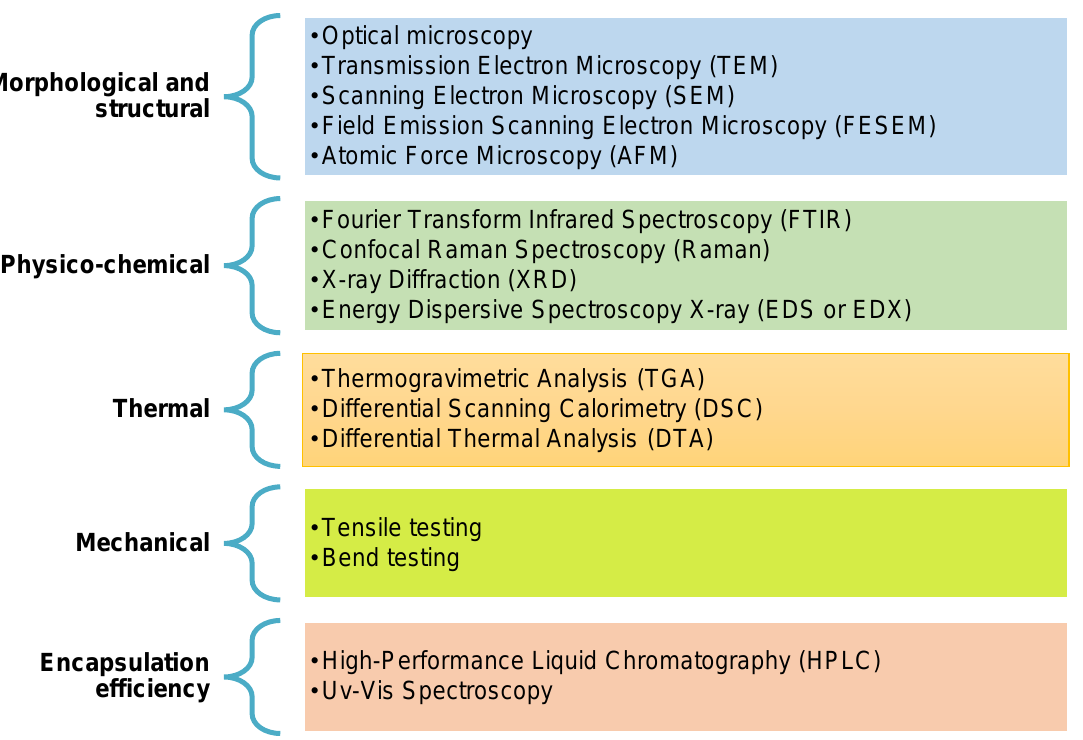
Figure 3. A summary of the main techniques used to characterize electrospun fibres and mats.